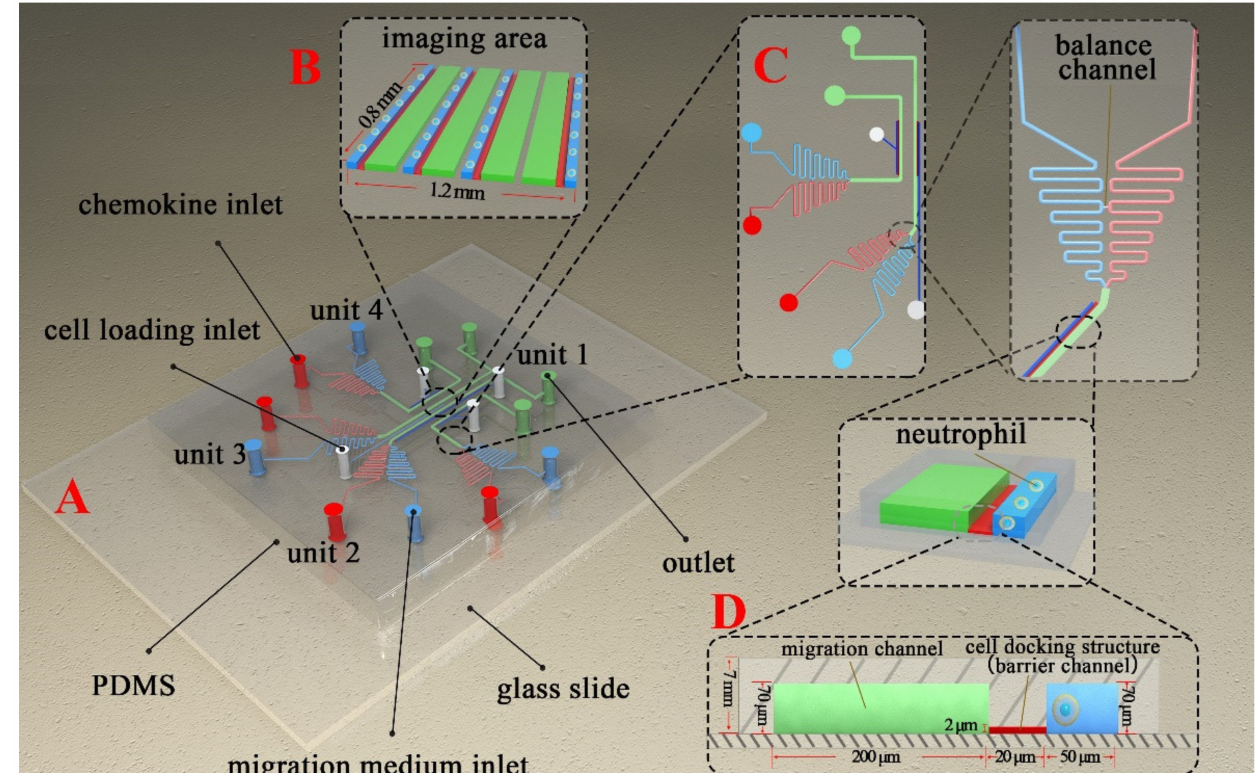
Figure 1. Schematic diagram of the F4-Chip used for cell chemotaxis research. ( A ) The isometric view of F4-Chip. ( B ) Enlarged view of the imaging area. ( C ) Enlarged view of unit 3 and unit 4. Each unit has its specific cell loading inlet, reagent inlet, and outlet. In addition, each unit has a balance channel to balance the pressure between the chemokine inlet and migration medium inlet. ( D ) The enlarged cell docking